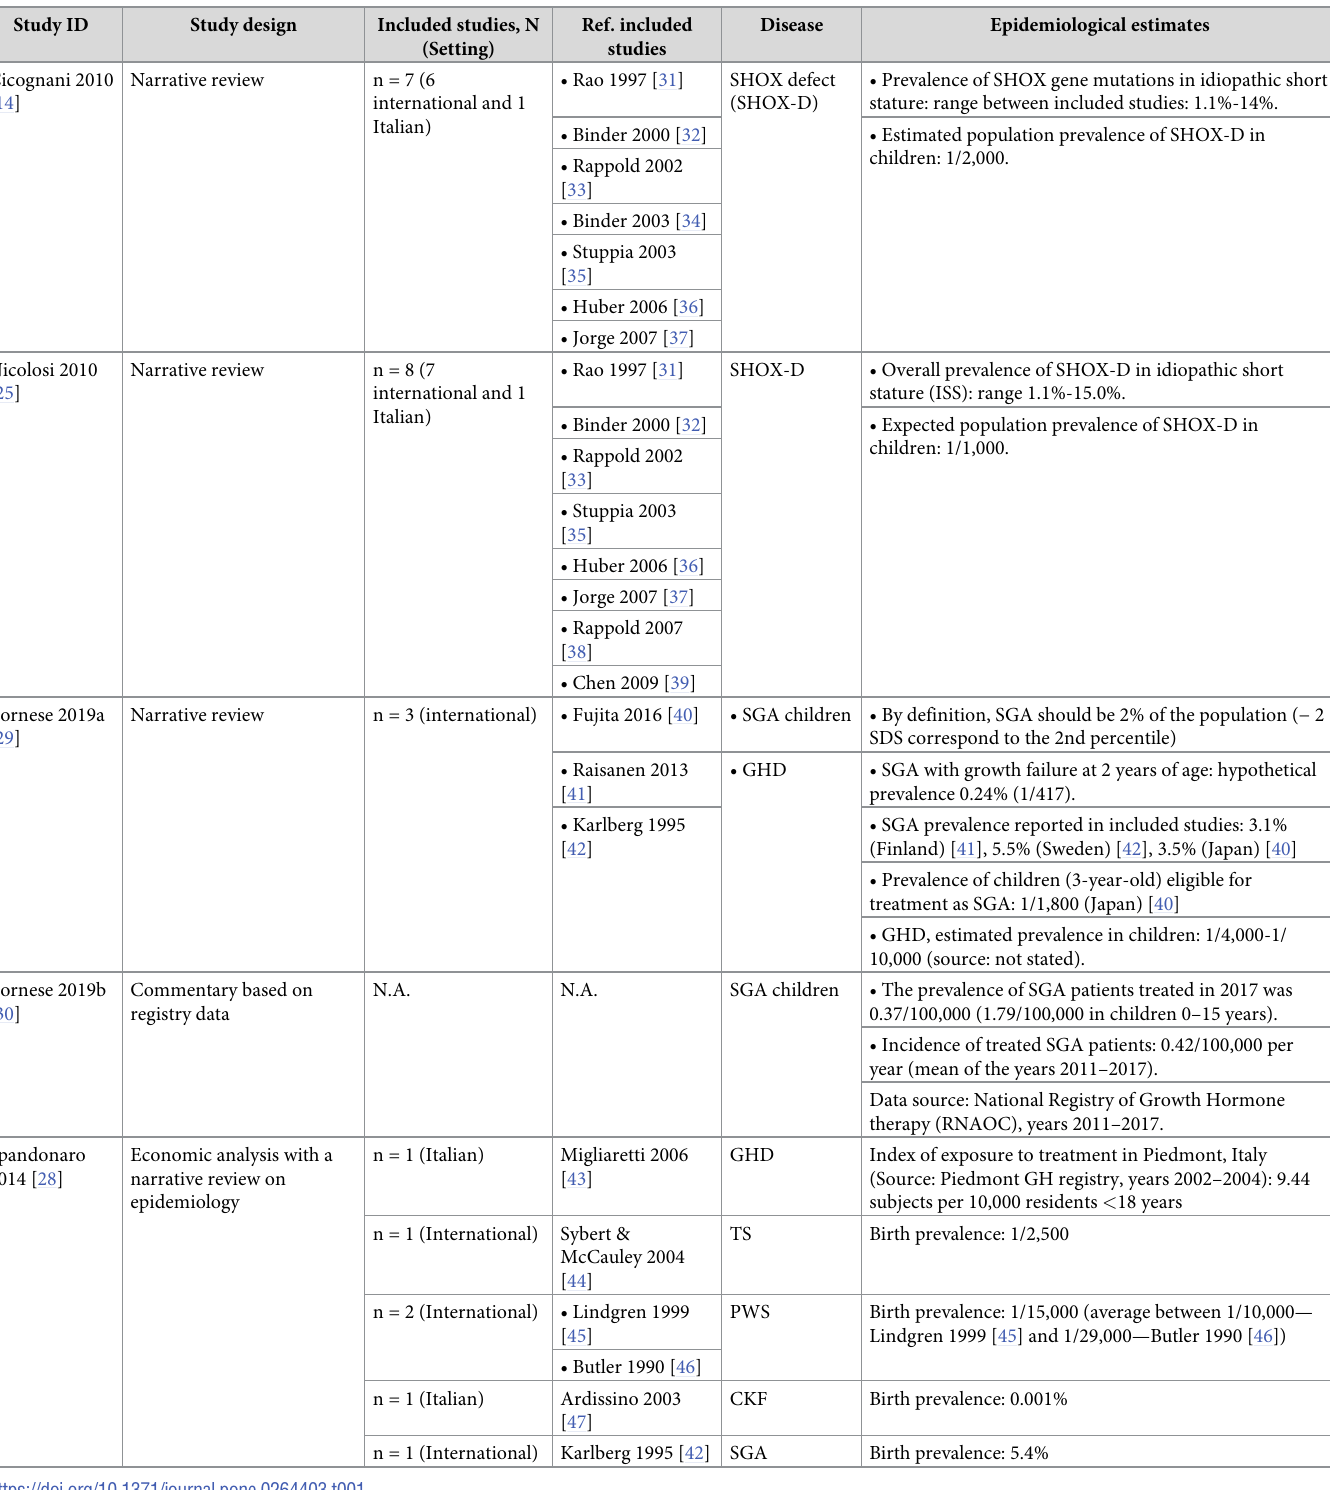
Table 1. Characteristics of included secondary studies for